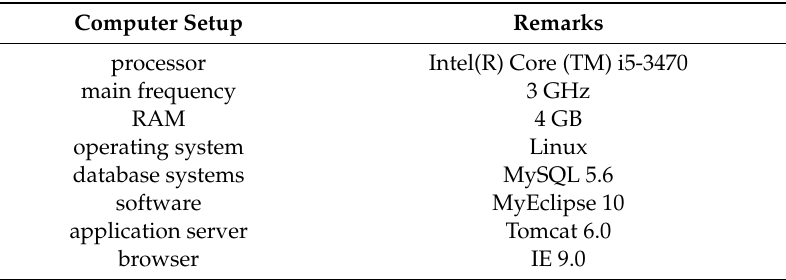
Table 2. Environment configuration.